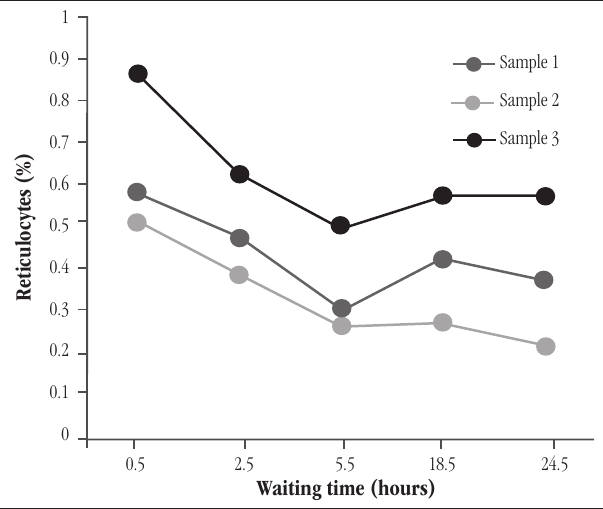
figurE 5 – Reticulocyte count (%) according to the waiting time (hours) for reading samples from donors, with normal reticulocyte value